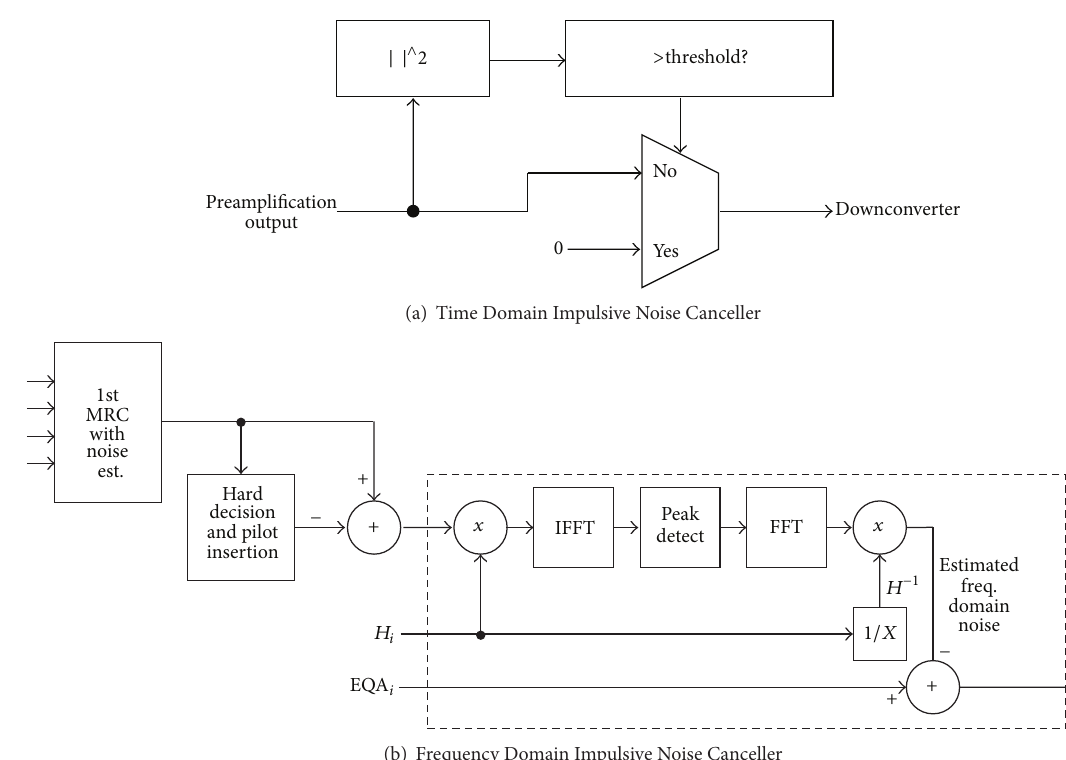
Figure 7: Time and Frequency Domain Impulsive Noise Canceller.